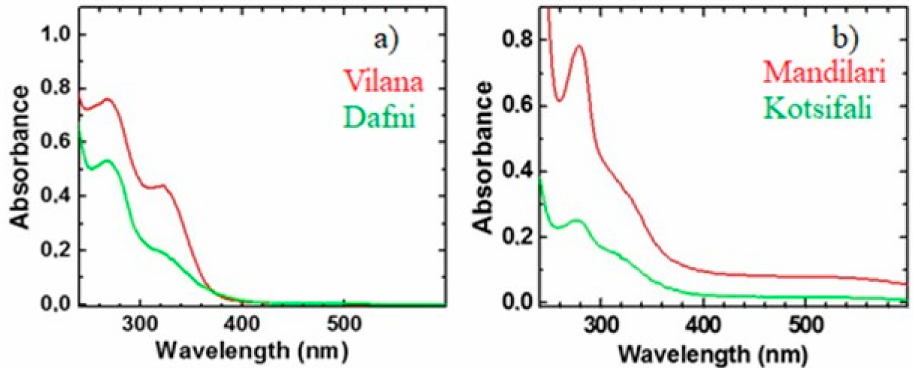
Figure 1. Typical Ultraviolet–Visible (UV-Vis) absorption spectra for ( a ) white wines (Dafni and Vilana) and ( b ) red wines (Kotsifali and